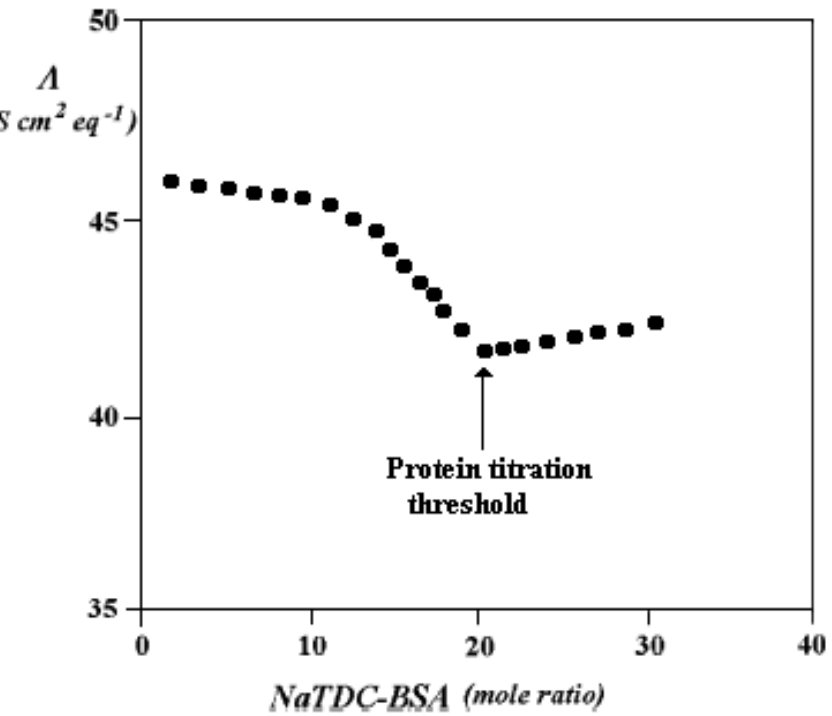
Figure 11. Equivalent conductance plot, Λ (in S cm 25.0 °C. The minimum in the curve indicates the protein titration threshold by NaTDC , and corresponds to a number of BS molecules per protein between 18 and 20. Its value increases when pH is lower than